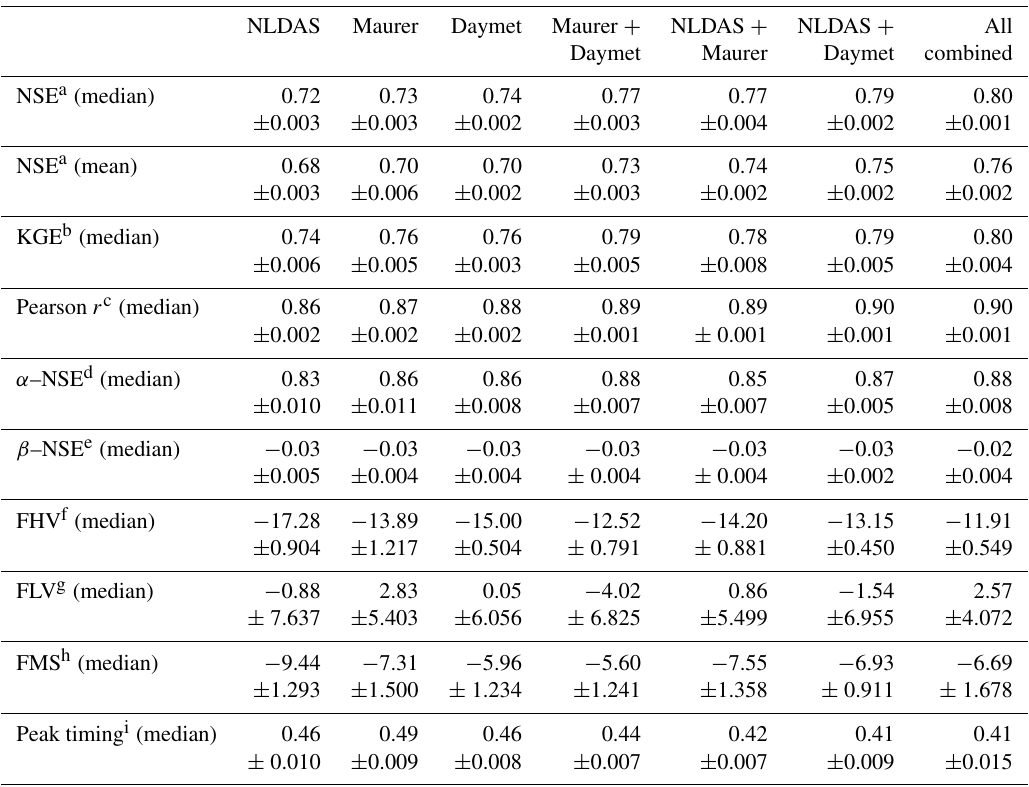
Table A1. Average single LSTM performance over a variety of metrics. The average single-model performances is computed as the mean of the metric of the n = 10 model